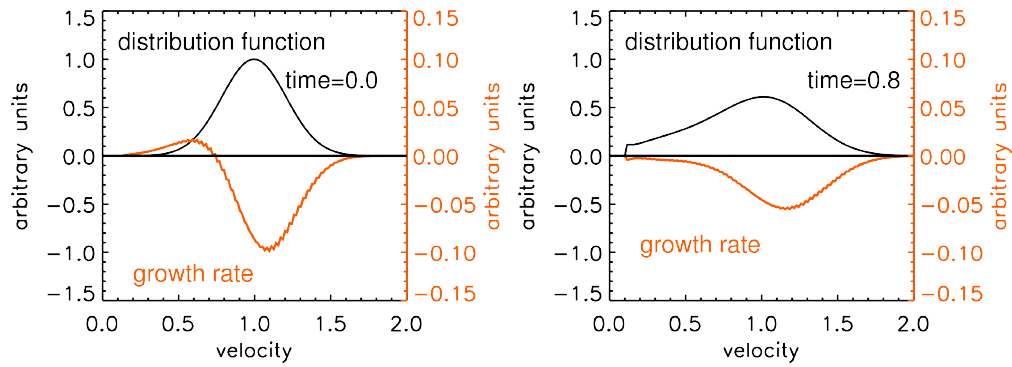
Fig. 3. The electron distribution function f (black) and the related Langmuir wave growth rate γ (red) (the x and y axis are same as in Fig. 1).